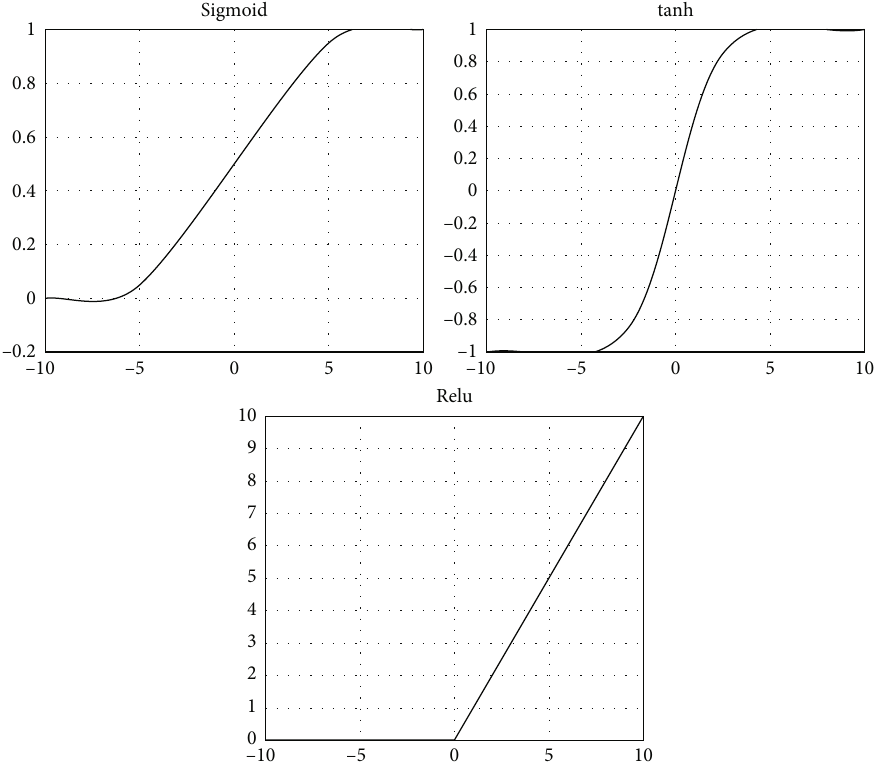
Figure 2: Three function images.